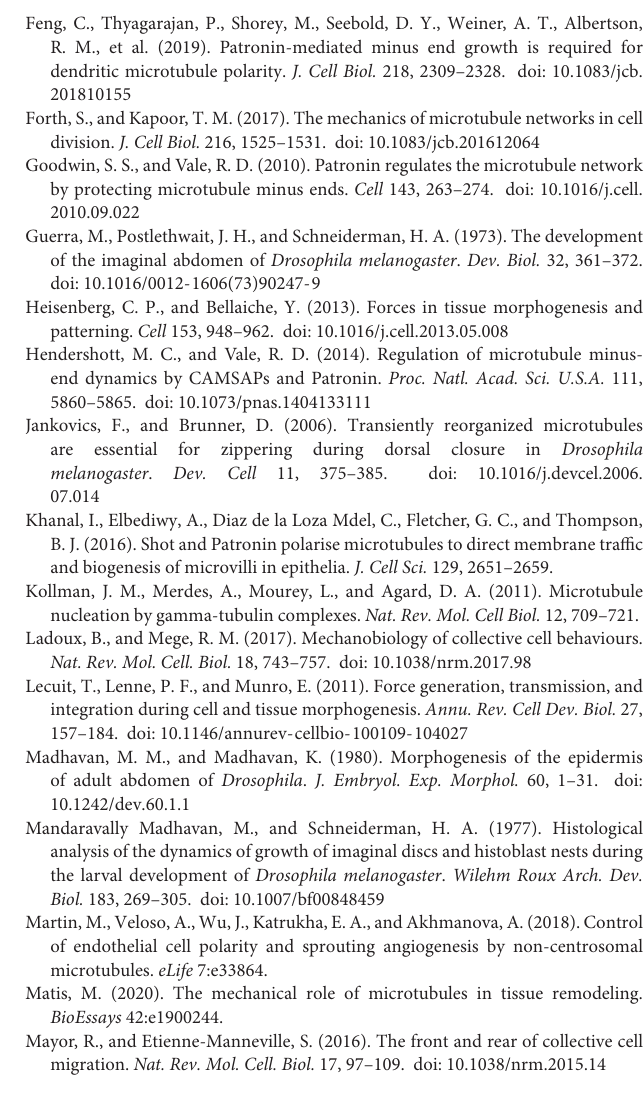
Supplementary Figure 4 | Leading and non-leading histoblast migrate same. Quantification of the speeds (A) and the straightness index (B) of leading (green) and non-leading epithelial cells (magenta). (A,B) . Bar plots are presented as mean ± SEM. Statistics (A,B) , Mann–Whitney U test, n.s., no significant difference; and p < 0.0001 (****). Number of leading cells ( n ) = 279, and pupae ( N ) = 3 and non-leading cells ( n ) = 1,392 and pupae ( N ) = 3. (C, D) Quantification of microtubule growth speed (C) and displacement length (D) in leading cells (green) and non-leading cells (magenta). Statistics (C,D) , Mann–Whitney U test (speed) p = 0.0241 and (displacement length) p < 0.0444. The number of leading cells for (C , D) ( n ) = 14 and pupae ( N ) = 3 and non-leading cells ( n ) = 14 and pupae ( N ) = 3. Developmental stage (A–B) : 26–30 h APF, (C–D) : 25–26 h APF. Supplementary Figure 5 | Histoblasts protrusions are enriched with actin and microtubules. (A) A representative confocal image showing migrating histoblast expressing membrane marker palm-mKate2. White arrowheads indicate protrusions in non-leading cells. (B,C) Cell protrusions in histoblasts are labeled with the membrane marker palm-mKate2 and microtubules with the plus-end marker EB1-GFP (B) and in panel (C) LifeAct-GFP marks actin. White arrowheads indicate the presence of microtubules (B) and actin (C) in protrusions. Developmental stage (A–C) : 25–26 h APF. Scale bars (A–C) , 5 µ m.